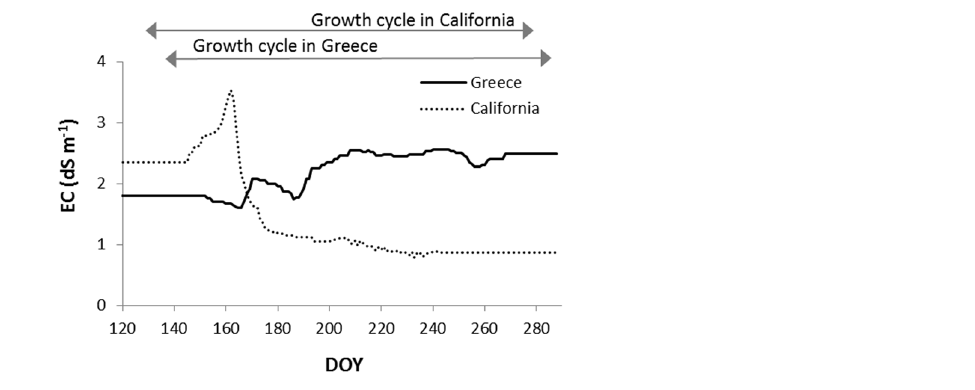
Figure 4. Seasonal electrical conductivity (dS m − 1 ) of field water for the two scenarios used for the ideotyping study, derived from Scardaci et al . 51 (California) and Lekakis et al . 54 (Greece). Salinity dynamics follow different patterns: in the Californian site the highest level of salinity is reached in the first part of the crop cycle whereas in the Greek one salt concentration increases gradually until mid-season and remains constant